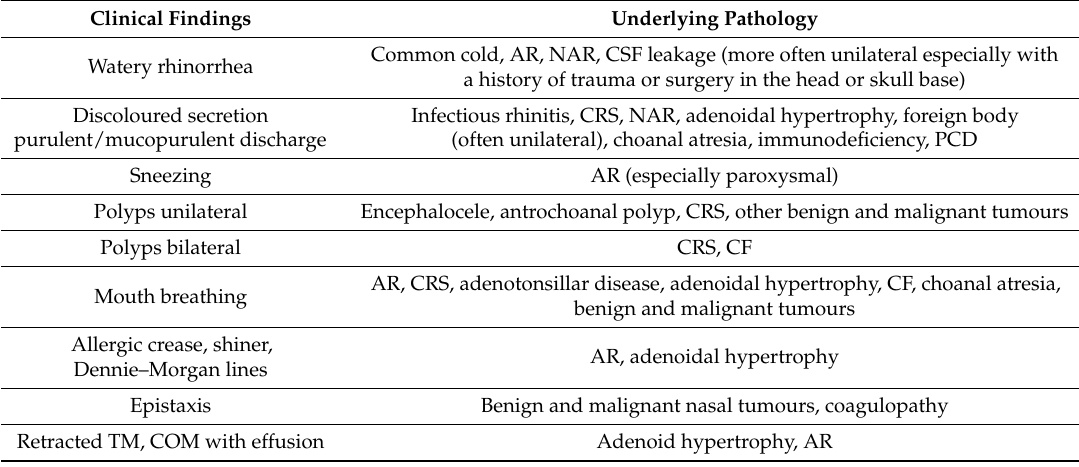
Table 3. Differentiating symptoms and signs of rhinitis in